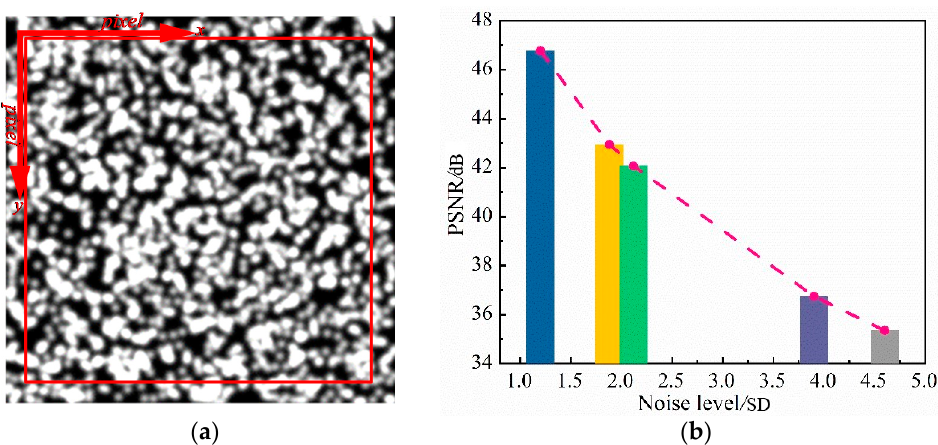
Figure 8. ( a ) Speckle pattern of the reference image used in numerical simulation; ( b ) PSNR under randomly selected noise.